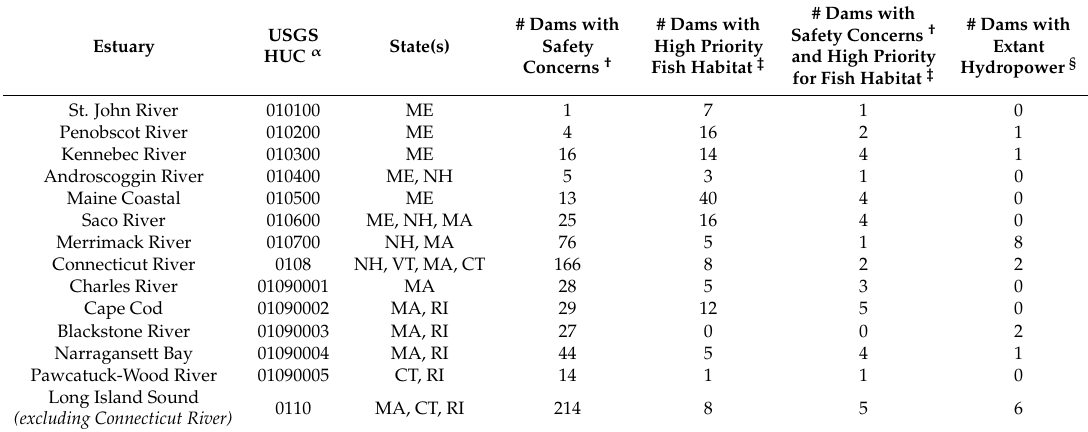
Table 5. Number of N removal dams in the drainage networks of different New England estuaries with values for anadromous fish restoration or safety